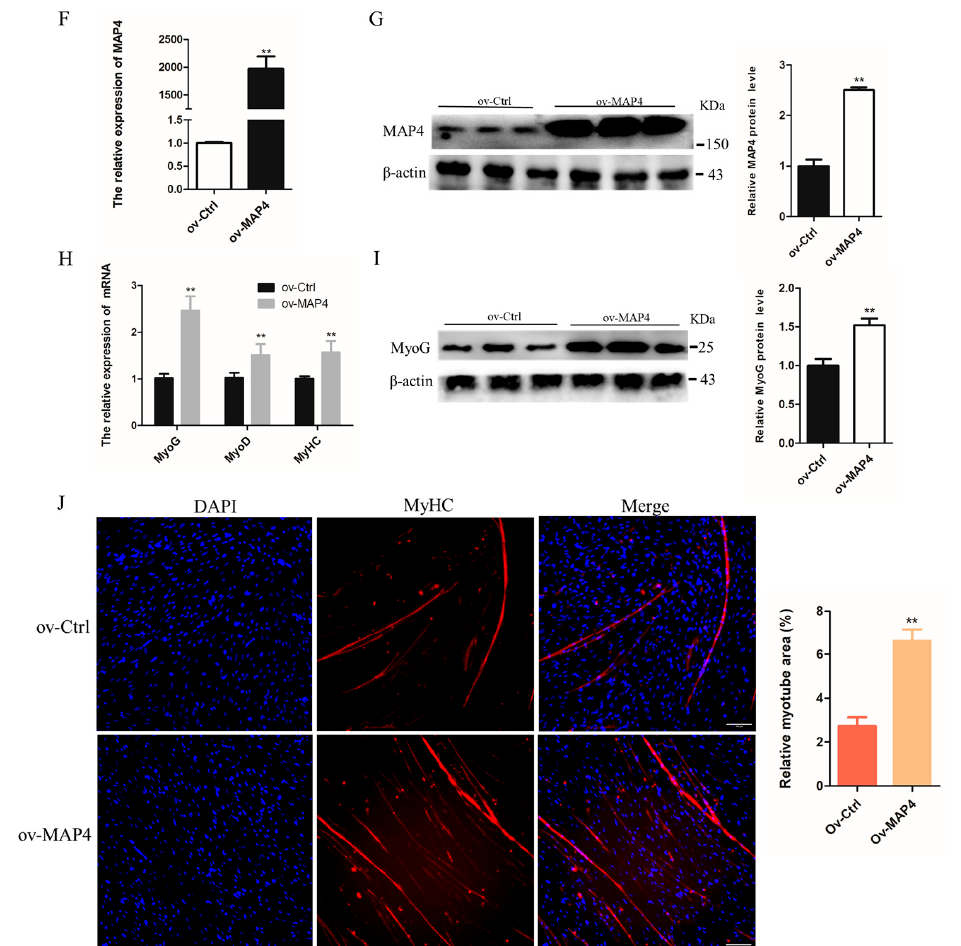
Figure 5. MAP4 promoted the differentiation of C2C12 cells. ( A , C , F , H ) The mRNA expression of MAP4 , MyoG , MyoD , and MyHC in C2C12 cells was detected by qRT-PCR at 24 h after transfection with MAP4 siRNA or MAP4-overexpressing plasmids. n = 3. ( B , D , G , I ) The protein expression of MAP4 in C2C12 cells was detected by western blot at 48 h after transfection with MAP4 siRNA or MAP4 -overexpressing plasmids. β -Actin was used as the endogenous control. n = 3. ( E , J ) Anti-MyHC immunofluorescence staining was performed in C2C12 cells at 48 h after transfection with MAP4 siRNA or MAP4 -overexpressing plasmids, and the relative myotube area was measured following MAP4 knockdown and overexpression. Scale bar = 100 μ m. n = 3. ** p < 0.01.